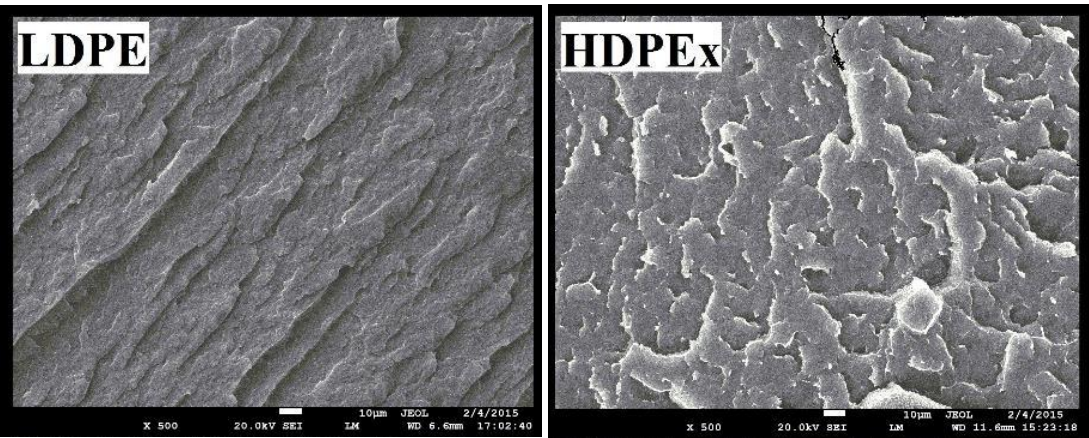
Figure 16. SEM—LDPE and HDPEx structure (500 × ).